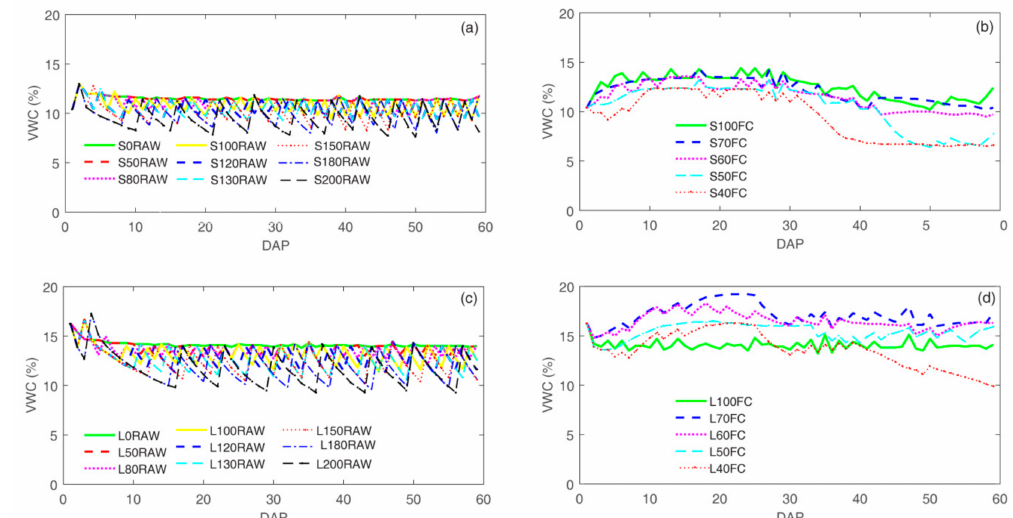
Figure 9. Daily soil moisture (VWC) response to different scenarios: ( a ) varied RAW threshold irrigation scenarios at site S1 (sand soil); ( b ) varied field capacity threshold irrigation scenarios at site S1; ( c ) varied RAW threshold irrigation scenarios at site S2 (loam soil); ( d ) varied field capacity threshold irrigation scenarios at site S2. RAW is readily available water content, S0RAW-S200RAW refers to irrigation scenarios with irrigation at 0–200% of RAW for sand soil. L0RAW-L200RAW refers to irrigation scenarios with irrigation at 0–200% of RAW for loam soil. S40FC-S100FC refers to deficit irrigation at 40–100% of field capacity for sand soil. L40FC-L100FC refers to deficit irrigation at